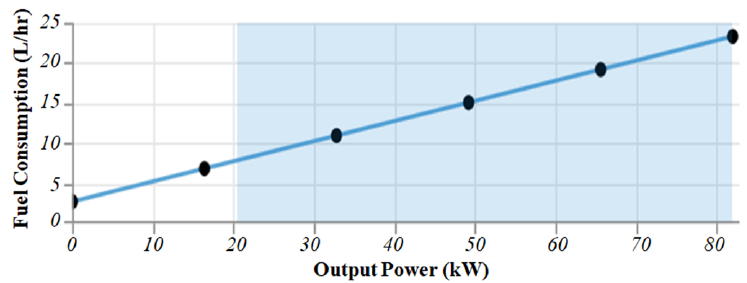
Figure 7. DG fuel curve.